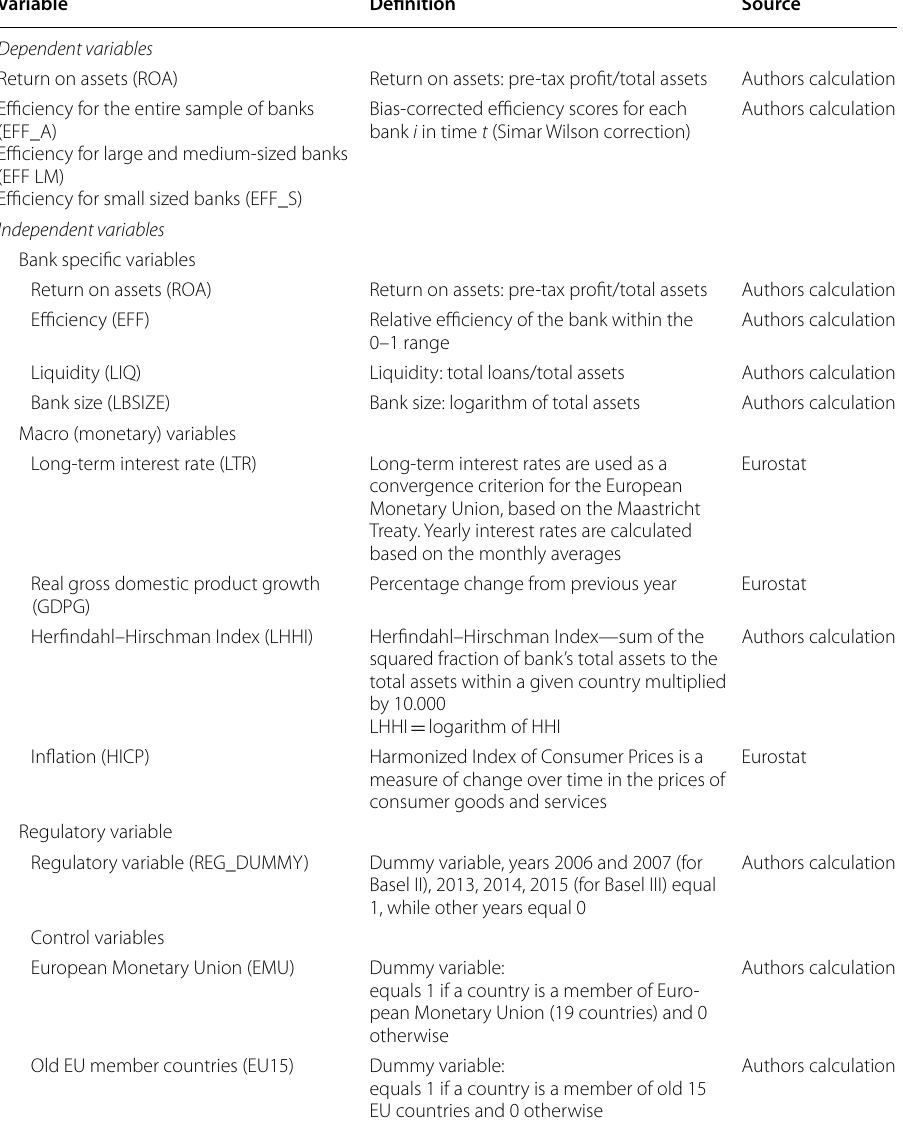
Table 4 List, definition, and source of variables used in dynamic panel data